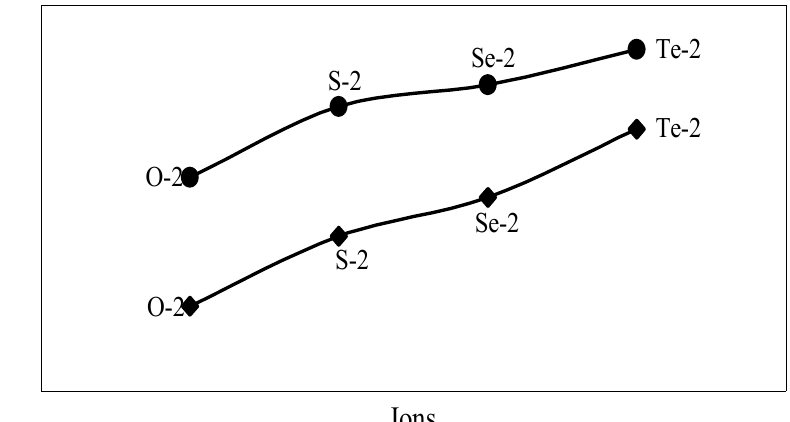
Figure 8. Plot of radii of dinegative ions of Gr-VIB elements.